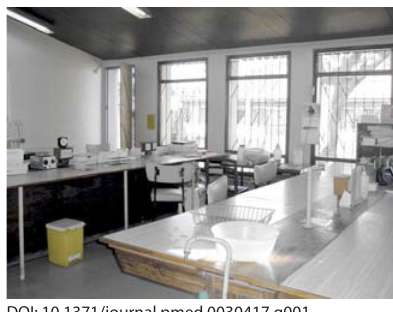
Figure 1. A Laboratory in